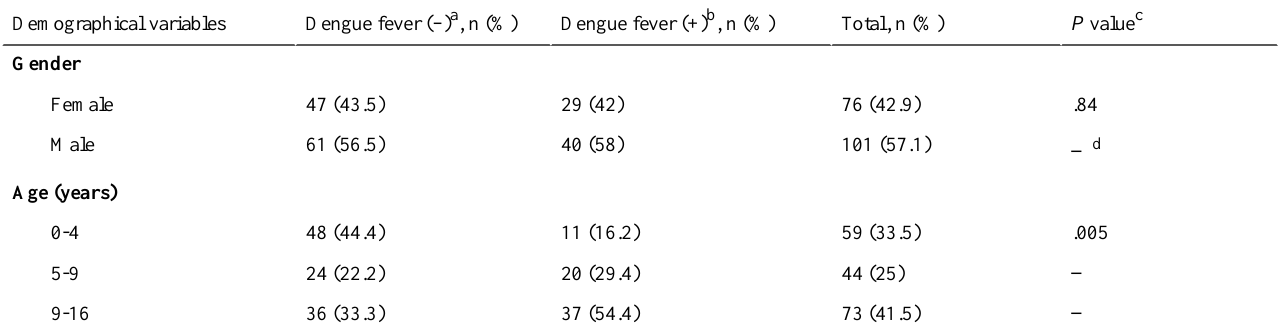
Table 1. Demographic characteristics of the study